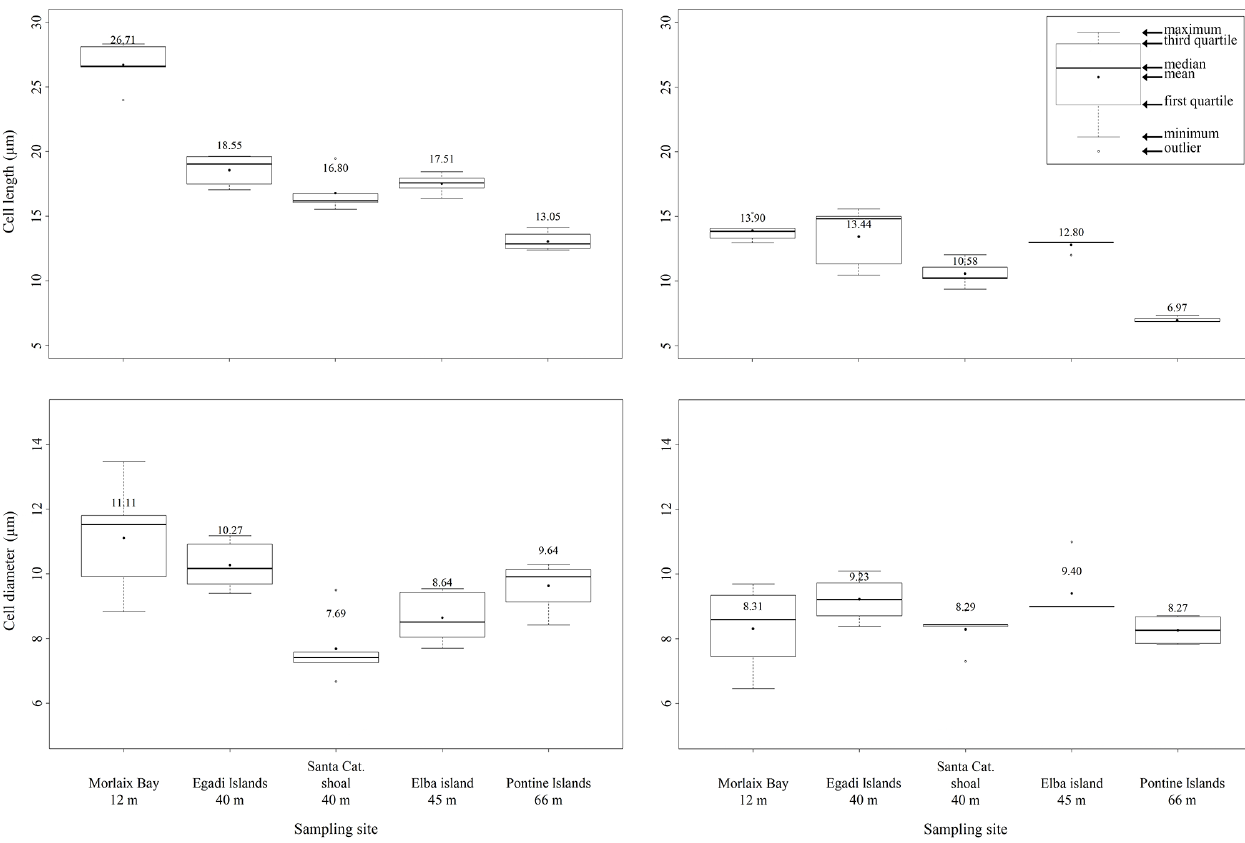
Figure 4. Box plots reporting cell lengths and cell diameters in both long and short cells of L . corallioides collected at different sampling sites and ordered along x axis according to the